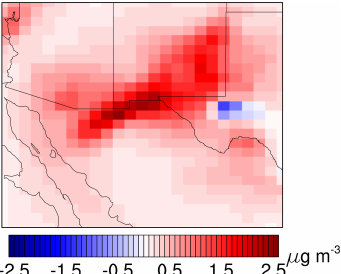
Figure 4. Simulated changes in springtime mean concentrations of fine dust over southwestern North America for the RCP8.5 fixed- CO 2 case, in which the effects of CO 2 fertilization are neglected. Changes are between the present day and 2100, with 5 years rep- resenting each time period. Results are from GEOS-Chem simula- tions at a 0.5 ◦ × 0.625 ◦